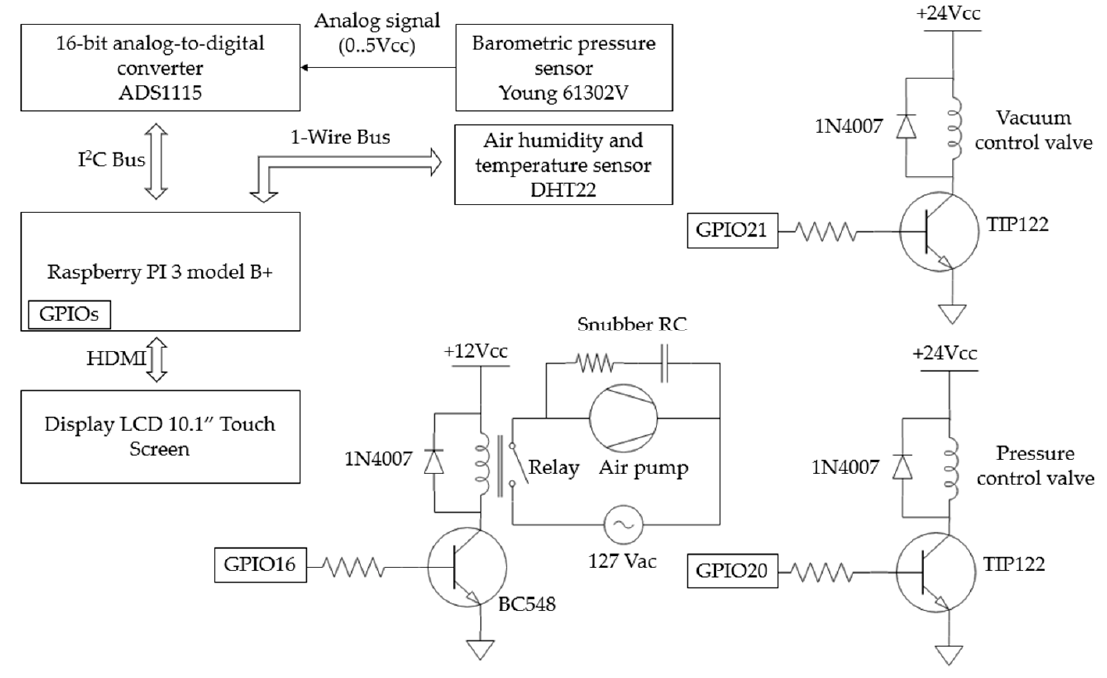
Figure 4. Diagram that represents the components of the electrical circuit responsible for the baro- metric chamber pressure control.